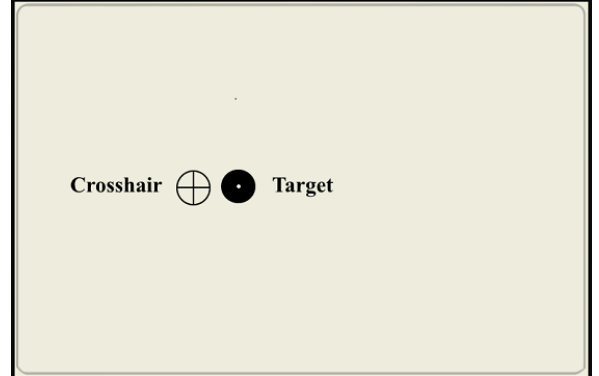
Figure 4: The experimental task.